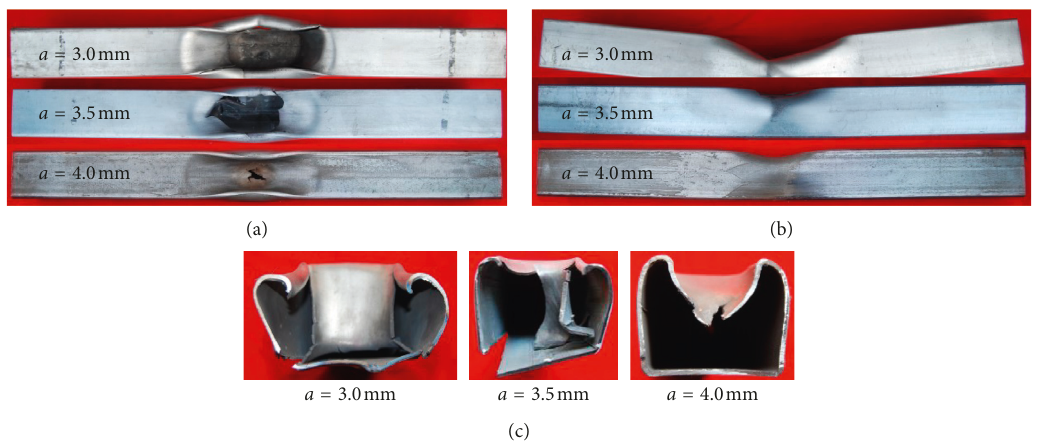
Figure 17: Damage of square tubes with different thicknesses at a stand-off distance of 12cm. (a) Planform view. (b) Side view. (c) Cross